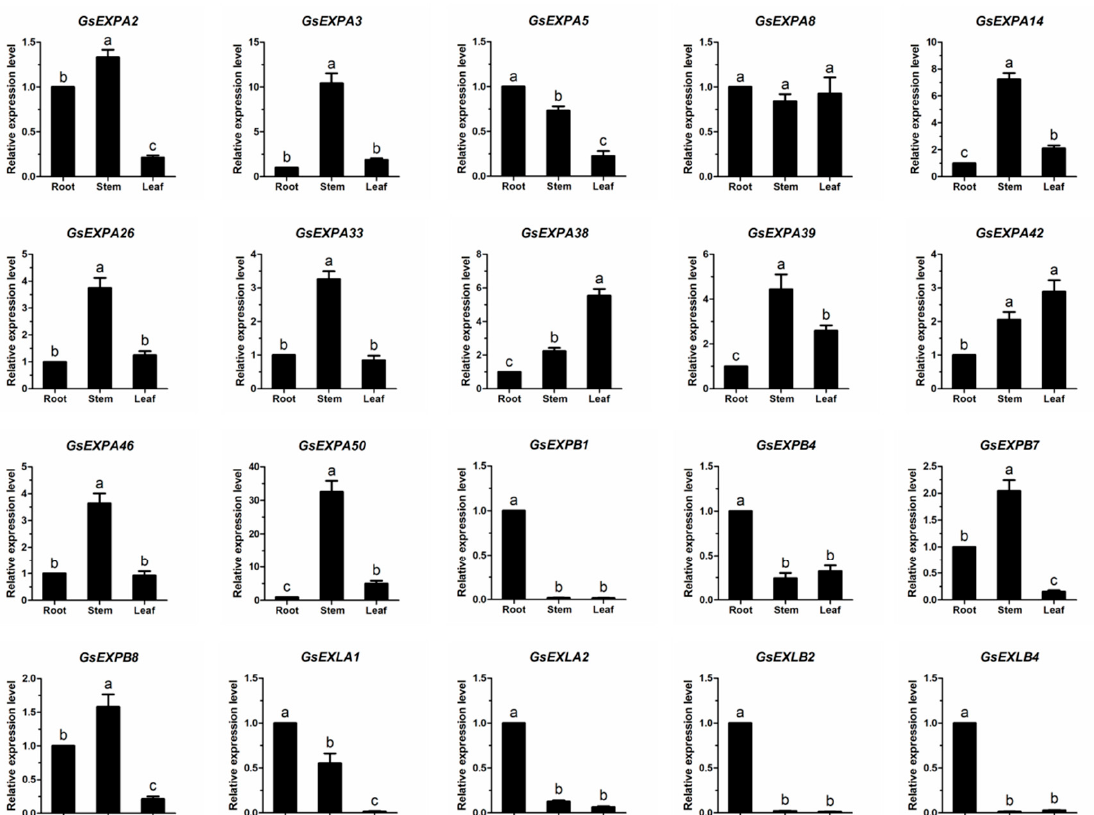
Figure 7. Expression levels of candidate 20 expansin genes detected by qRT-PCR in wild soybean root, stem, and leaf. Different small letters indicate that the transcription levels of expansin genes in different organs is significantly different ( p < 0.05).